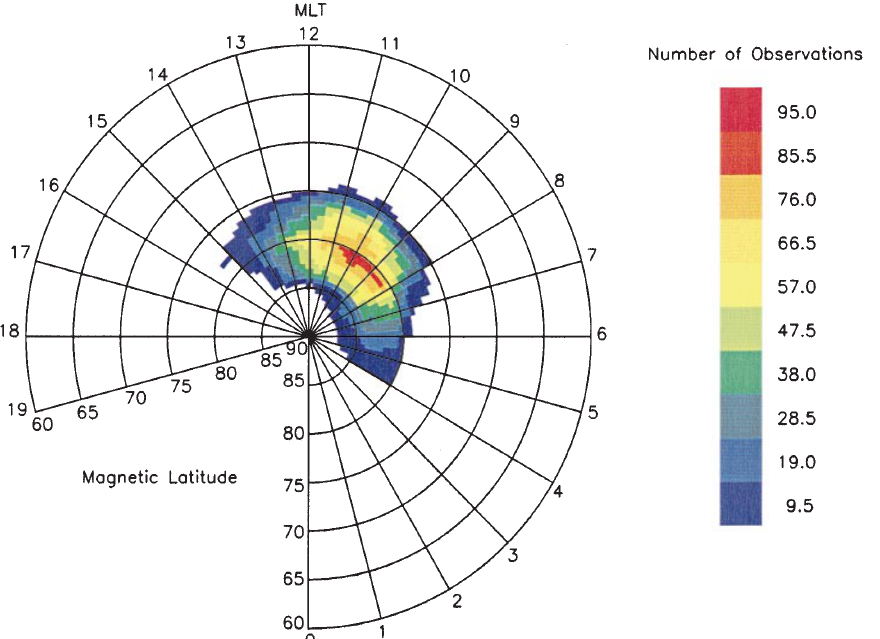
Fig. 4. Occurrence distribution in lati- tude and MLT of PIF signatures, as observed by the CUTLASS Finland radar from March 1995 to February 1997 when run in high-time and normal